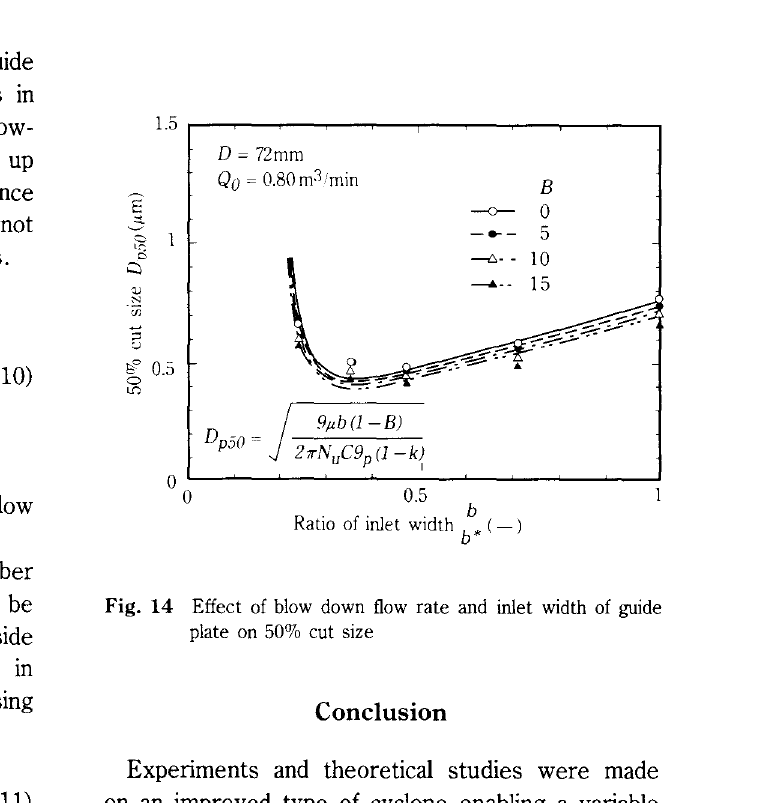
Fig. 14 Effect of blow down flow rate and inlet width of guide plate on 50o/o cut